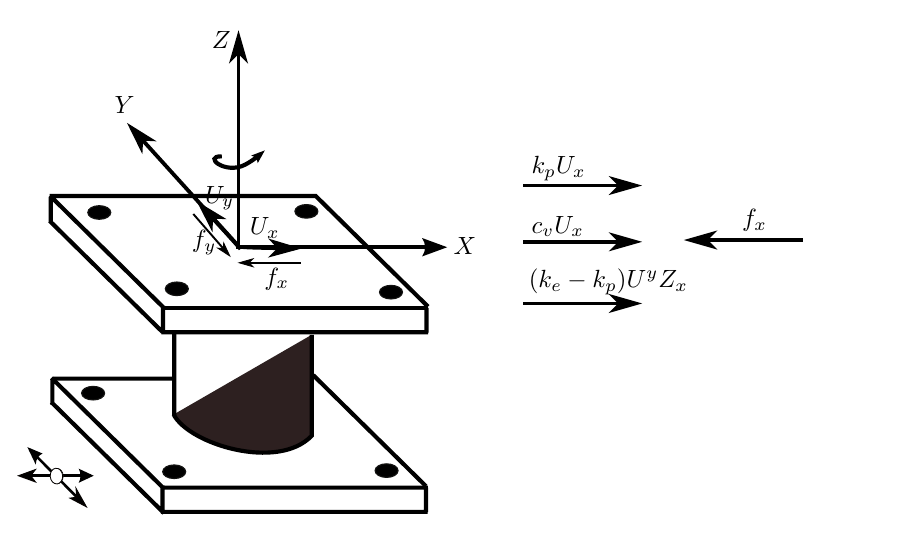
Figure 4. Forces equilibrium at the